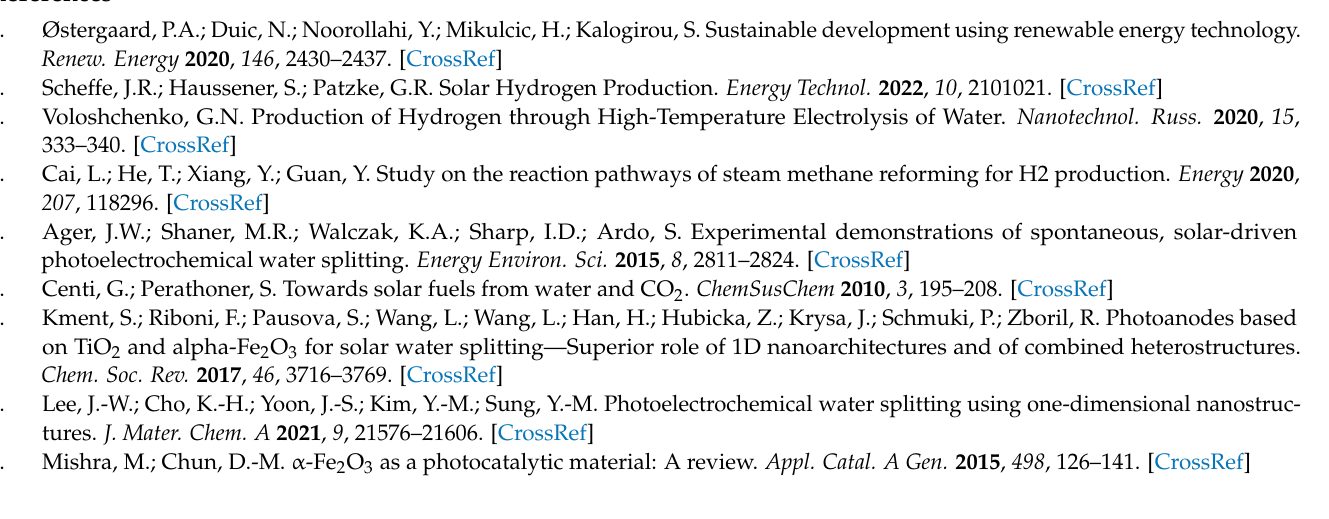
Materials; Table S2. ICP and ICP-MS of Fe 2 O 3 (FT) and Ce-doped Fe 2 O 3 (1CFT, 5CFT, 10CFT); Figure S1. XPS Valence of Fe 2 O 3 (FT) and Ce-doped Fe 2 O 3 (1CFT, 5CFT, 10CFT). (a); Ti 2p (b); Figure S2. UV-vis absorption profile of Fe 2 O 3 (FT) and Ce-doped Fe 2 O 3 (1CFT, 5CFT, 10CFT). (a) and optical bandgaps, inset is the refined spectrum of 0.4–1.7eV (b); Figure S3. (a) Photocurrent density versus the monochromatic light; (b) IPCE values; Figure S4. Electrochemical impedance spectroscopy (EIS) and Equivalent Circuit of Fe 2 O 3 nanorods and Ce doped Fe 2 O 3 nanorods samples; Table S3. Fitting data for each component in the fitted circuit for each sample; Figure S5. (a) Mott–Schottky plots collected at 1.5 kHz at a linear potential region between 0.2 to 0.6 V vs. RHE and (b) Calculated carrier densities of Fe 2 O 3 (FT) and Ce-doped Fe 2 O 3 (1CFT, 5CFT, 10CFT)